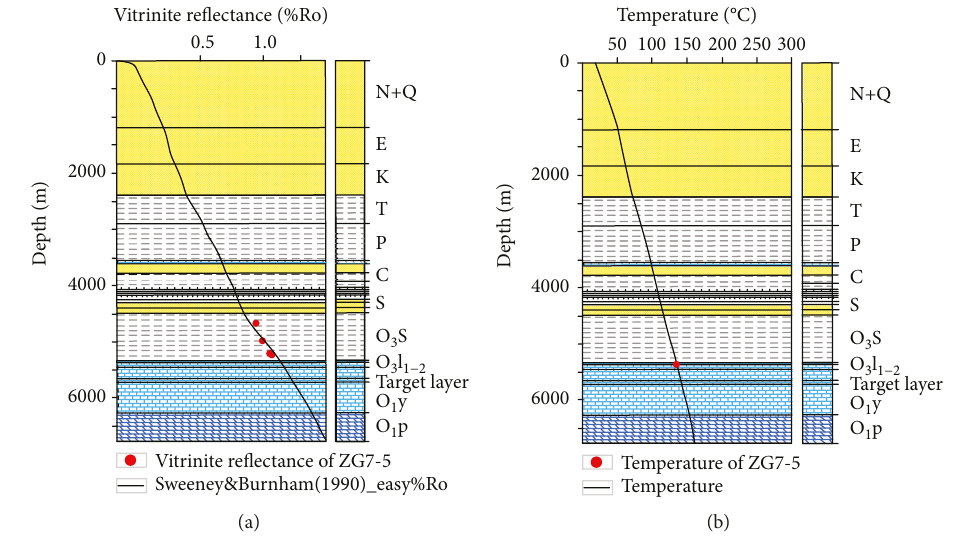
Figure 5: Good fi t between the measured temperature and maturities and the modeled results of Well